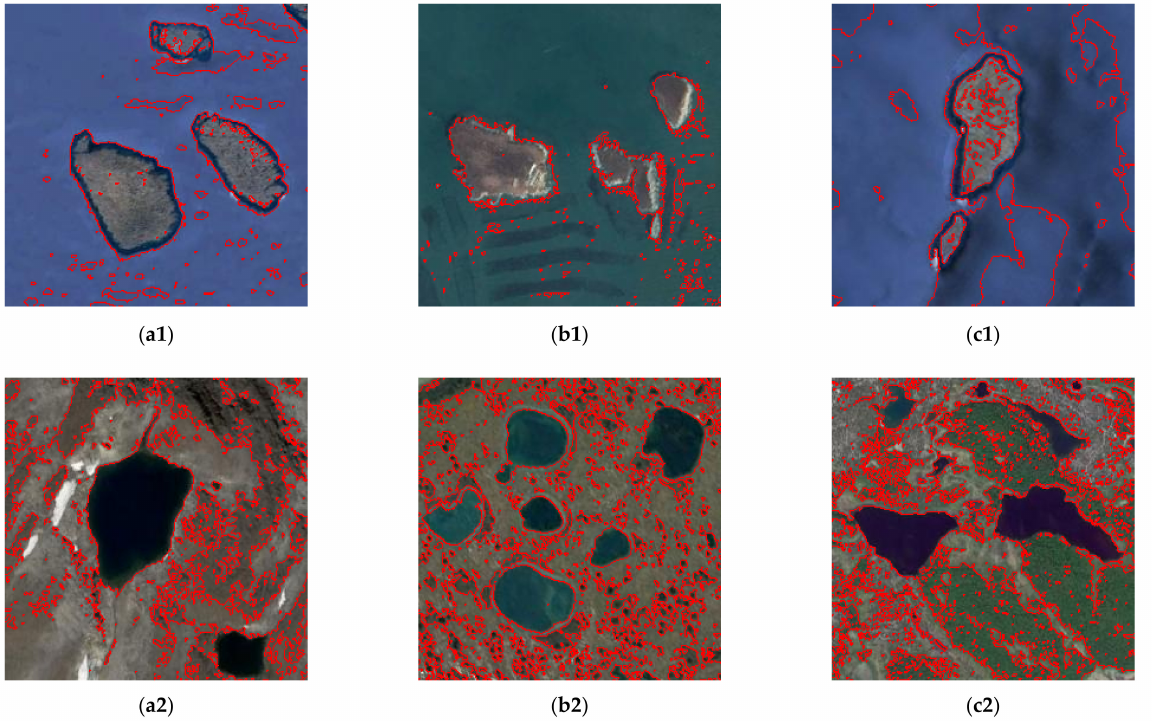
Figure 16. Experimental results based on pixel algorithm: ( a1 ) Island image 1; ( b1 ) Island image 2; ( c1 ) Island image 3; ( a2 ) Lake image 1; ( b2 ) Lake image 2; ( c2 ) Lake image